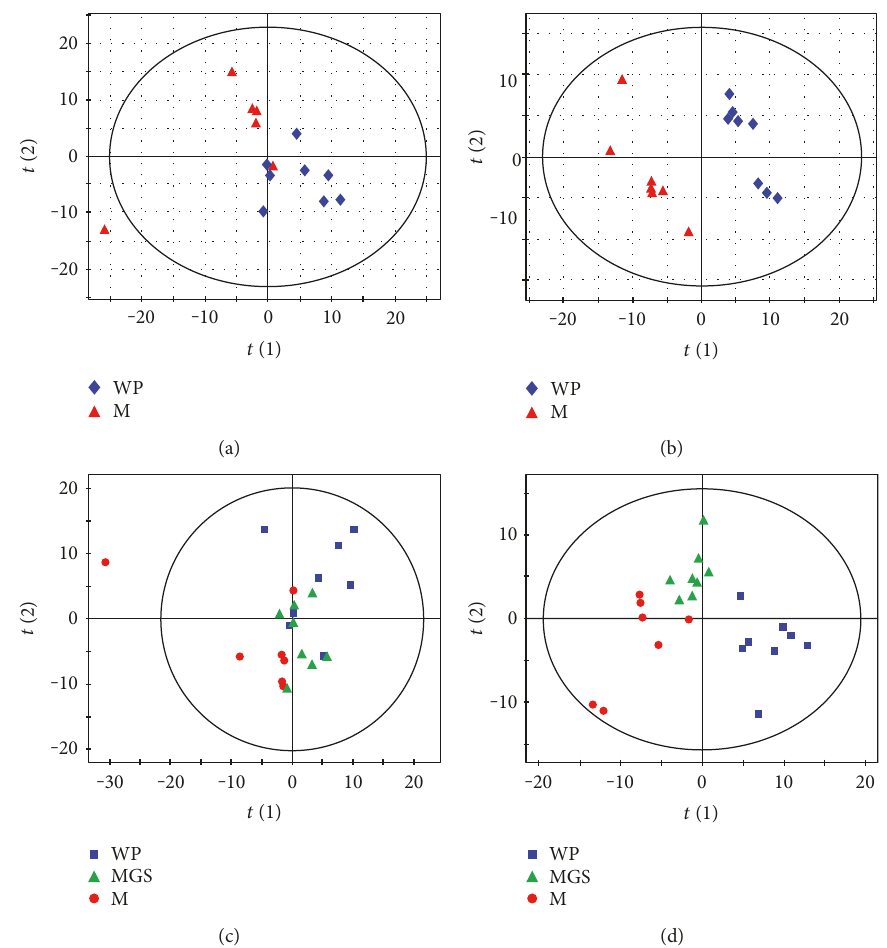
Figure 2: Score plots of multivariate statistical analysis on serum samples. (a) PCA score plot of wide platform (WP) group versus model (M) group, (b) PLS-DA score plot of wide platform (WP) group versus model (M) group, (c) PCA scores plot of WP, M, and MGS groups, (d) PLS-DA score plot of WP, M, and MGS